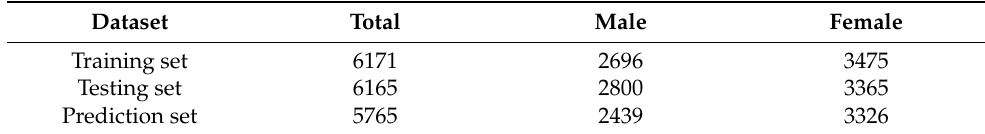
Table 2. The Distribution of Datasets.